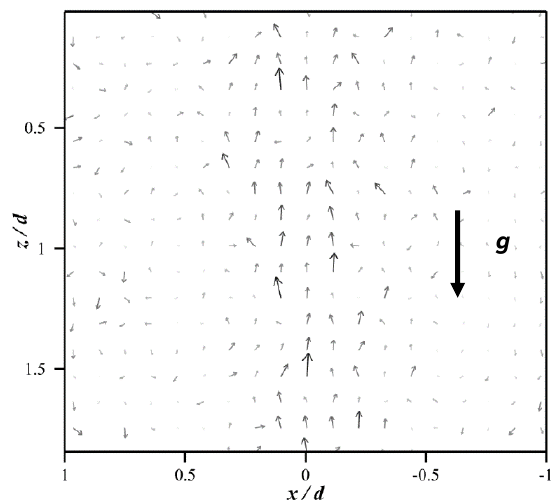
Figure 6. The negative wake at 7 d downstream from the particle center.